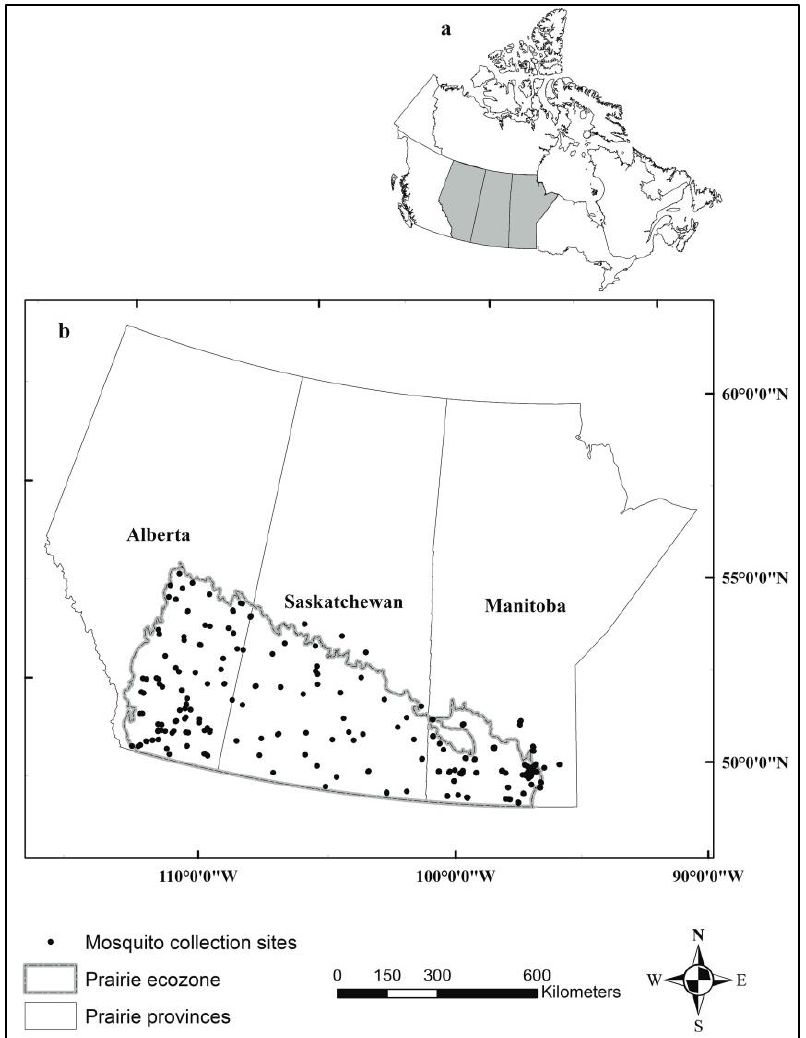
Figure 1. Distribution of mosquito sampling sites in the Canadian prairies provinces of Alberta, Saskatchewan, and Manitoba for the period from 2005 to 2008. ( a ) Location of prairie provinces (grey spot) in Canada. ( b ) The distribution of sampling sites across the Canadian prairies